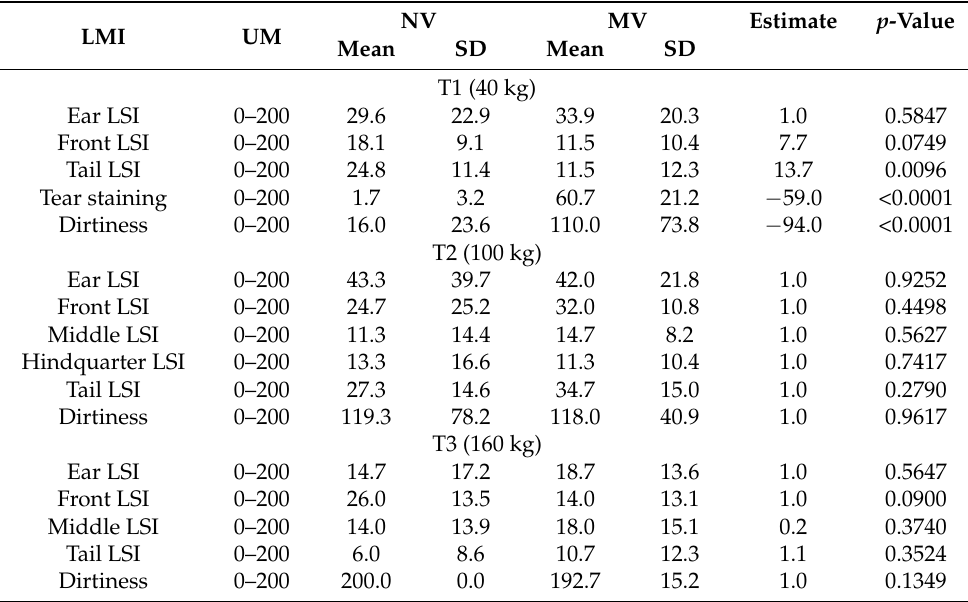
Table 5. Lesions and health measures observed in the study in the two buildings.